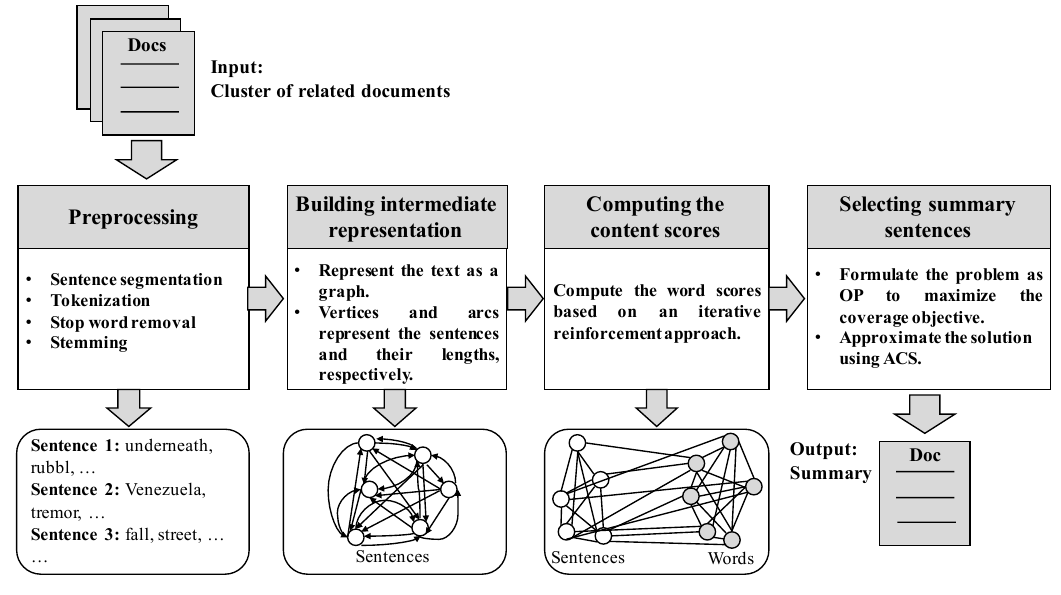
Figure 1. The main architecture of multi-document text summarization–orienteering problem